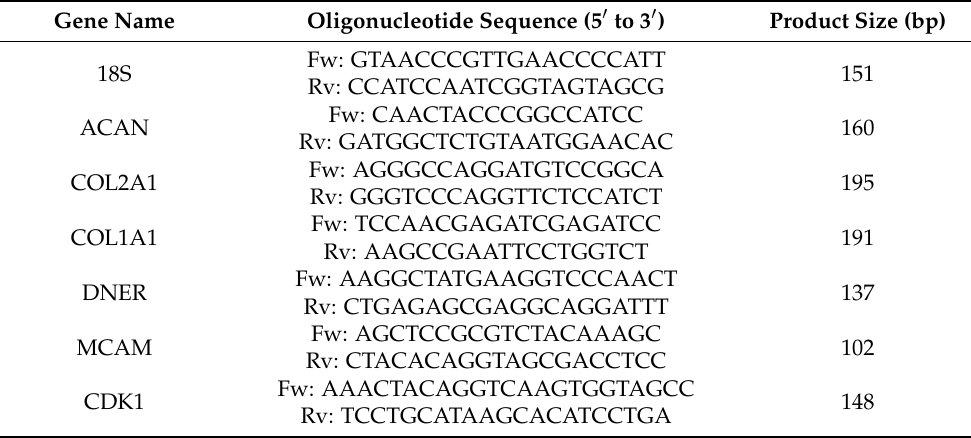
Table 1. Primer sequences for quantitative real-time PCR. ACAN, aggrecan; bp, base pair; COL1A1, collagen type I alpha 1 chain; COL2A1, collagen type II alpha 1 chain; CDK1,